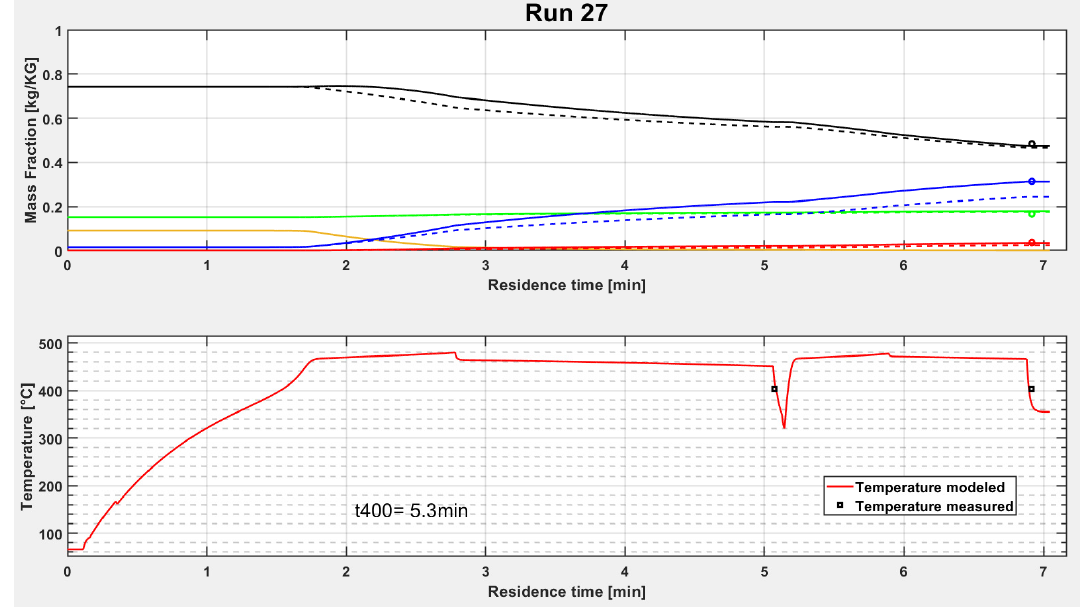
Figure 7. Trends of mass fraction of the lumps and the temperatures over the time for test run 27 with 10% PP. The residence time with temperatures higher than 400 °C is 5.3min for this test run.